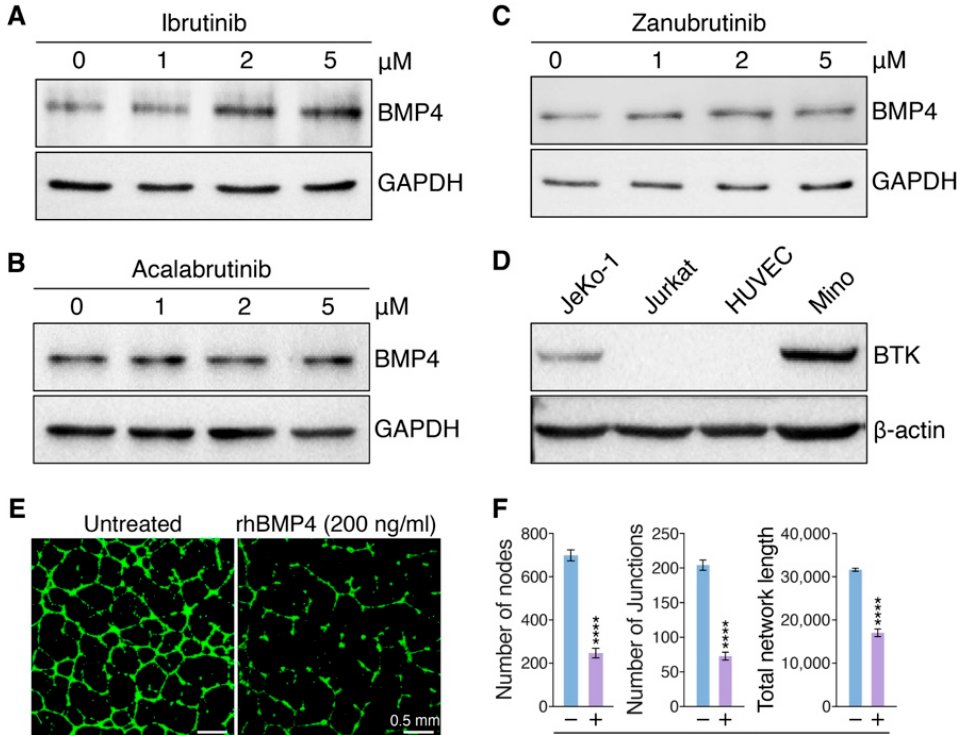
Figure 4. Ibrutinib-induced BMP4 disrupts vascular dysfunction. Analysis of protein expression of BMP4 in HUVECs. Endothelial cells were treated with Ibrutinib ( A ), Acalabrutinib ( B ) or Zanubru- tinib ( C ) in a dose-dependent manner as indicated and immunoblot analysis of BMP4 expression was conducted. GAPDH was used as loading control. ( D ) Immunoblot analysis of BTK expression in HUVECs. Two MCL cell lines, JeKo-1 and Mino, were considered as positive controls of BTK expression, and a T-cell lymphoma cell line, Jurkat, was considered as negative control of BTK expres- sion. β -actin was used as loading control. ( E ) The net-like structure of endothelial cells on Matrigel was decreased by the treatment of rhBMP4 (200ng/mL), which was observed under fluorescence microscopy after staining endothelial cells with Calcein AM. Scale bars, 0.5 mm. ( F ) Quantification of nodes, junctions and total network length of endothelial networks from ( E ) by ImageJ software ( n = 5). Data are shown as mean ± SEM; **** p < 0.0001, as calculated using the Student’s t -test. Considering the more angiogenesis effect of Ibrutinib, we hypothesized that neutraliza- tion of BMP4 could be a potential strategy for reducing the strong suppressed angiogenesis of Ibrutinib on vascular integrity. Thus, we tested if anti-BMP4 mAb could impair the capac- ity of Ibrutinib to disrupt vascular integrity via neutralizing the function of BMP4 induced by Ibrutinib treatment. HUVECs were treated with or without Ibrutinib (1 µ M or 2 µ M) in the presence or absence of anti-BMP4 mAb (2 µ g/mL), and anti-BMP4 mAb significantly counteracted the effect of Ibrutinib on vascular integrity disruption (Figure 5A–D). These data suggested that blocking BMP4 might be a potential strategy to relieve the bleeding effect caused by Ibrutinib-induced vascular